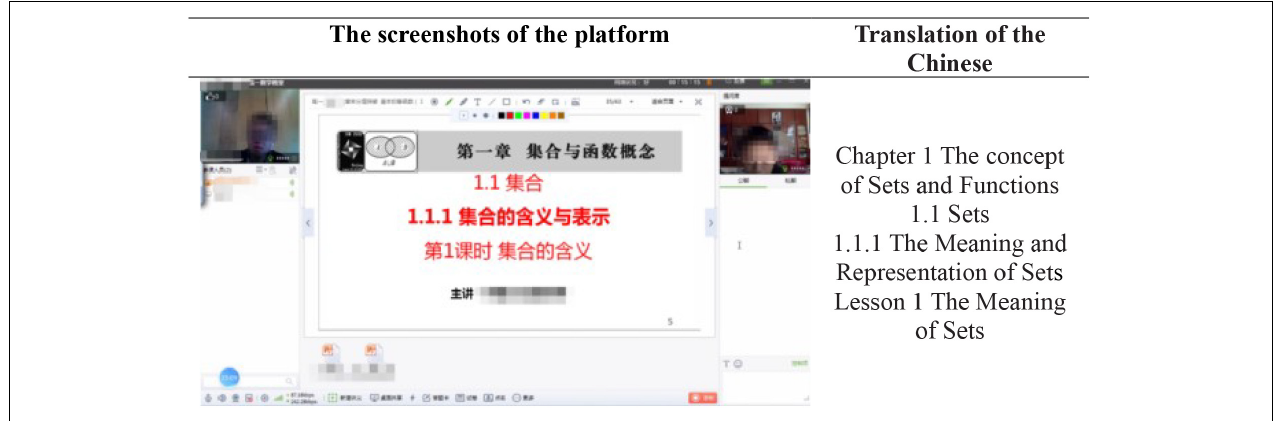
FIGURE 1 | Screenshots of the platform and its translation in English.